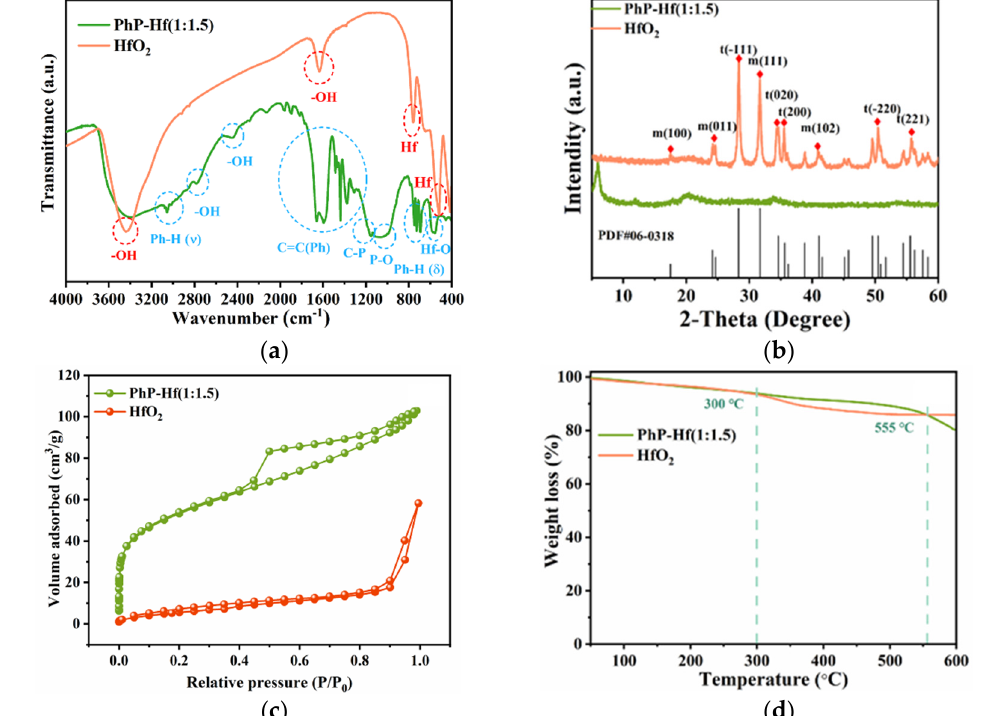
Figure 2. ( a ) FT-IR spectra; ( b ) XRD patterns; ( c ) N 2 adsorption-desorption isotherms; ( d ) TG curves of PhP-Hf (1:1.5) and HfO 2 . Table 1. Physical and acid-base properties of HfO 2 as well as fresh and reused PhP-Hf (1:1.5).